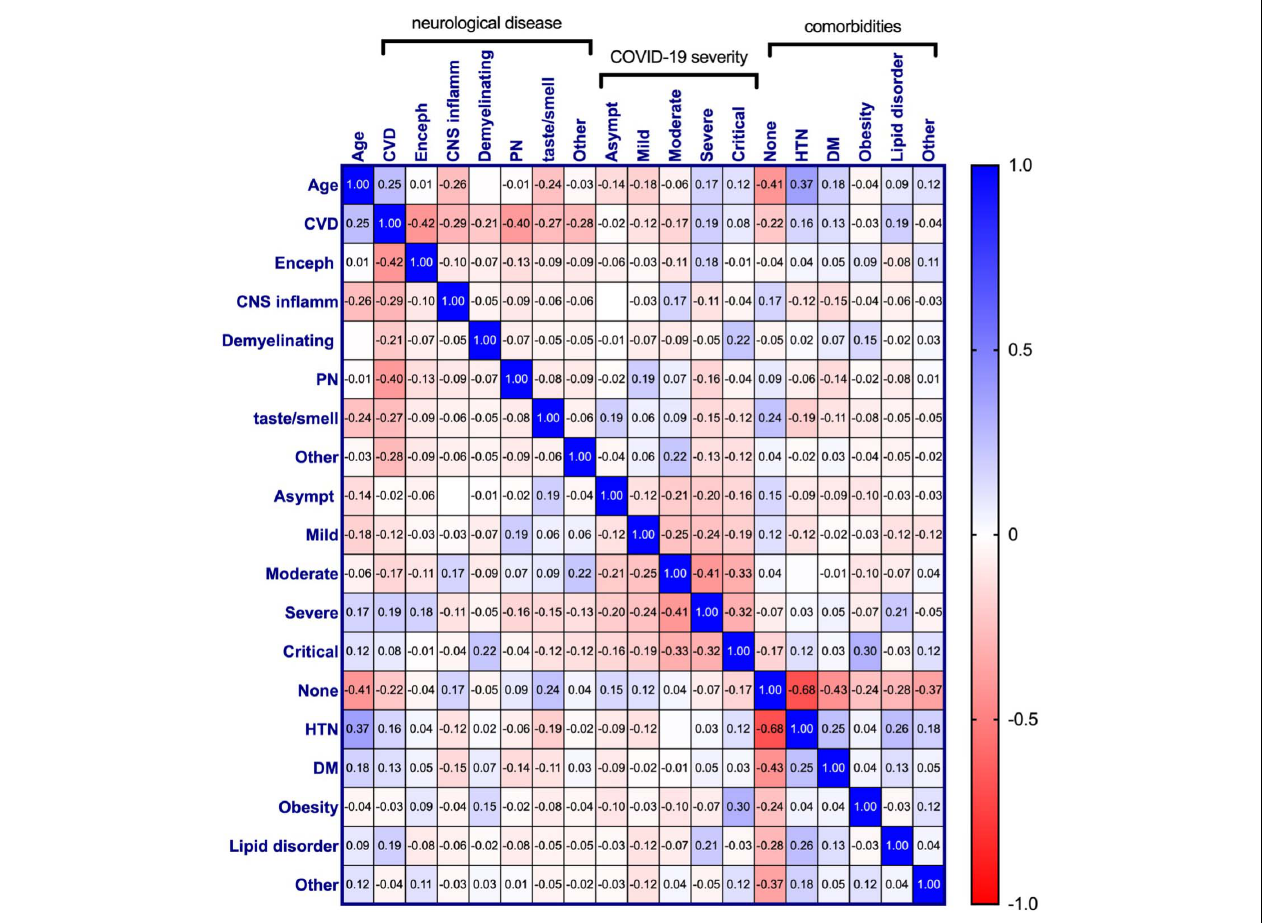
FIGURE 7 | Pearson correlation matrix for age, neurological disease, COVID-19 symptom severity, and comorbidities of COVID-19 patients diagnosed with a neurological condition(s) (n = 303). Pearson’s correlation coefficients are displayed and assigned color based on the distance from zero, with blue representing positive and red representing negative correlations. CVD, Cerebrovascular disease; Enceph, Encephalopathy; CNS inflamm, Central nervous system inflammatory disease; PN, Peripheral neuropathy; Asympt, Asymptomatic; HTN, Hypertension; DM, Diabetes